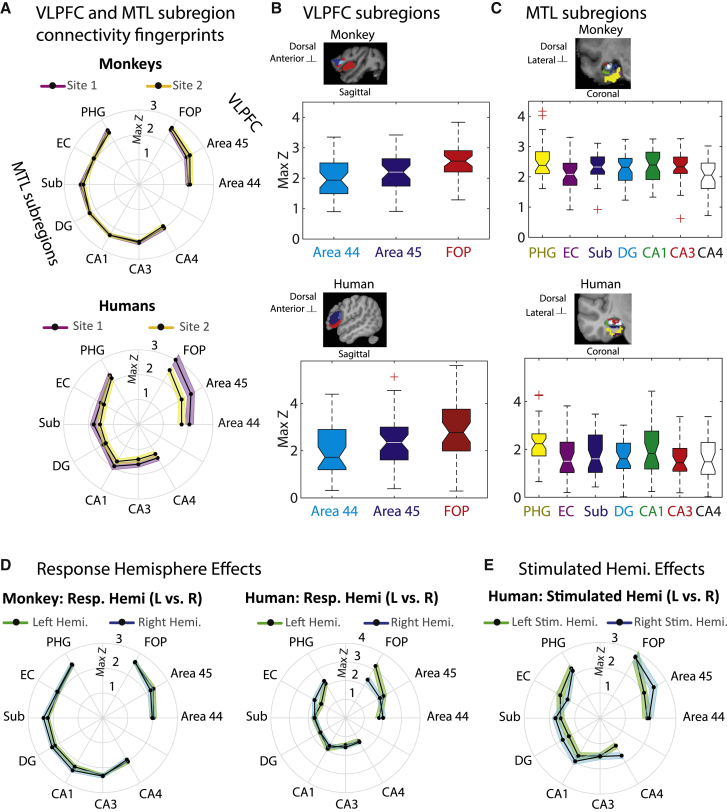
Human and macaque VLPFC and MTL connectivity profiles(A) VLPFC and MTL subregion es-fMRI effects displayed as polar plots. Shown are across scanning run peak Z values and variability (±SEM [standard error of the mean]). Top plot in (A) shows monkey results; bottom plot shows human results.(B and C) Whisker plots of VLPFC (B) and MTL (C) es-fMRI activity responses (across scanning runs, peak Z value; central mark identifies the median; edges of box are 25th and 75th percentiles; whiskers extend to extreme ends of data, not including outliers in red crosses; non-overlapping notches are significantly different at p < 0.05). Also shown are sagittal and coronal slices in each species with the anatomically localized ROIs used for the analysis.(D) Effects by response hemisphere (monkeys left, humans right).(E) Human effects by stimulated hemisphere; only right hemisphere was stimulated in the monkeys.Note that the joined lines in the polar plots are not intended to suggest a continuing pattern across ROIs, only to assist in comparison of the patterns across species (A) and hemispheres (D and E); also see the whisker plots in (B) and (C).